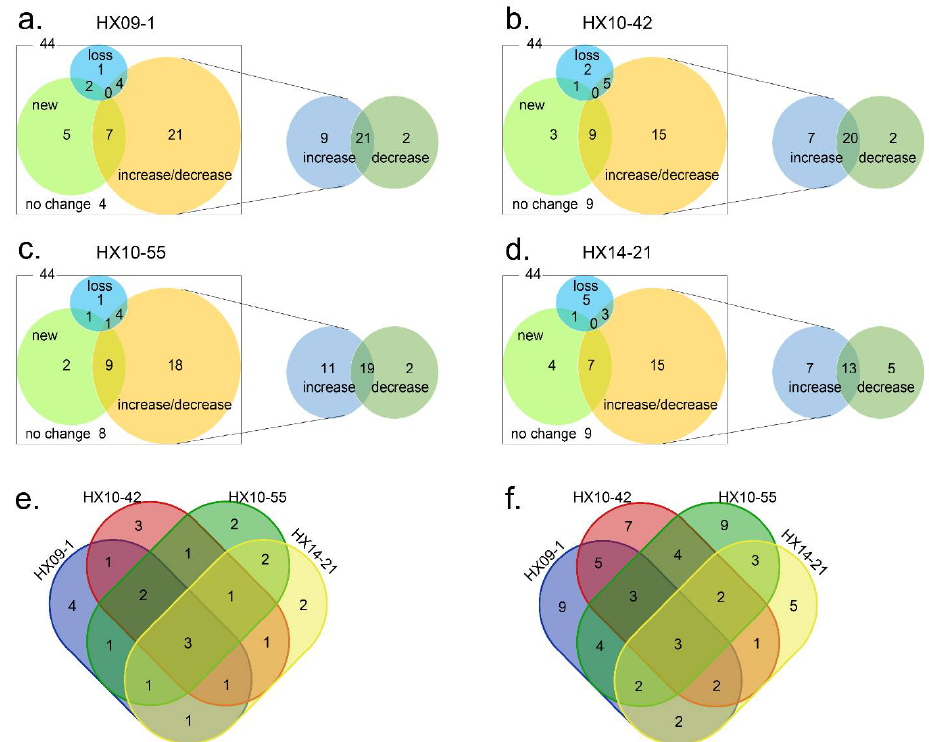
Figure 2. Venn diagrams showing effects of co-culture with four different MACB on the SM profiles of 44 red soil-derived streptomycetes. Pure cultures were used as controls. The numbers represent the number of streptomycetes or co-culture pairs. ( a – d ) Summarization of the effects of co-culture for each MACB. Each HPLC profile was classified according to the aforementioned categories: increase/decrease, the yields of original metabolites produced in pure cultures increased/de- creased in the co-cultures (the integral area of HPLC peaks changed by more than 30%); new, “new” metabolites with unique retention time and/or UV absorption that exclusively appeared in the co-cultures; loss, original pure culture me- tabolites lost in the co-cultures; and no change, no difference in SM profiles was detected between the co-cultures and pure cultures. The increase/decrease part is subclassified into increase, decrease, and both increase and decrease in the right panel. ( e ) Overlaps of the effects between MACB on inducing “new” metabolites. ( f ) Overlaps of the effects between MACB on increasing the yields of original metabolites.